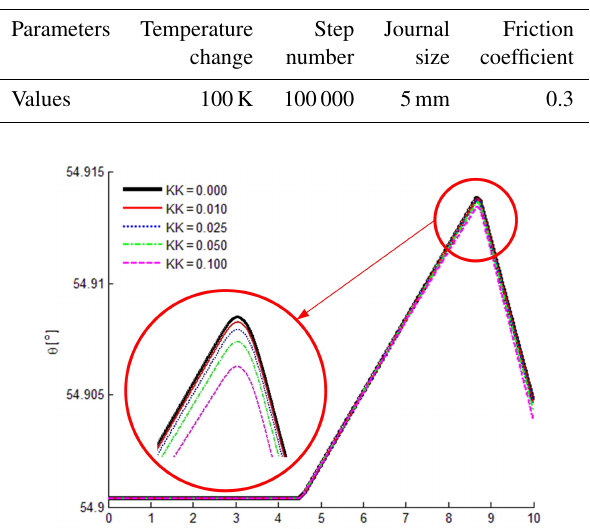
Table 3. Simulation parameters of dynamic solution process.